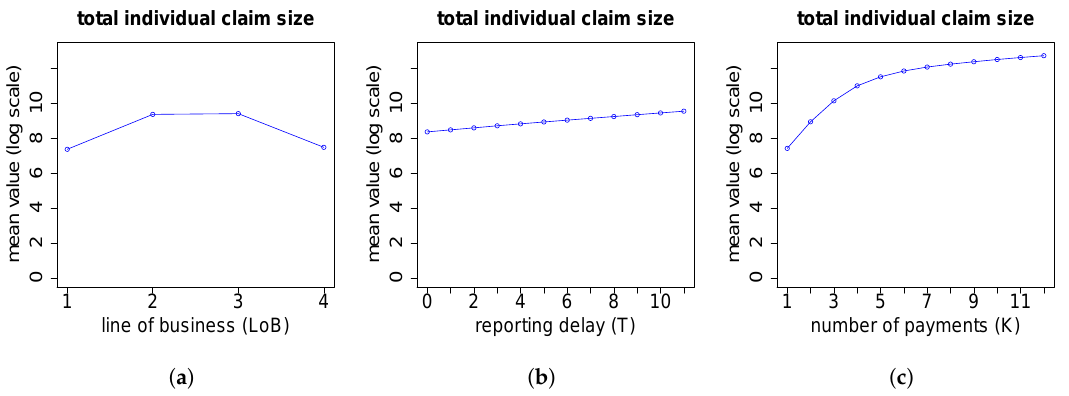
Figure A9. Total individual claim size Y (on log scale) w.r.t. the features ( a ) LoB ; ( b ) reporting delay T and ( c ) number of payments K